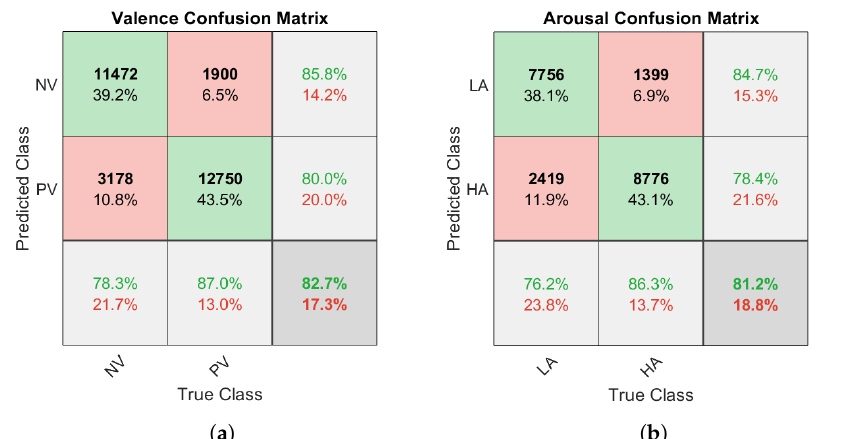
Figure 4. Confusion matrices for the 10-NN classifier in the valence ( a ) and arousal ( b ) dimensions. Figure 5a,b show the confusion matrices for the Ensemble Bagged Tree classifier for the valence and arousal dimensions, respectively. In this case, the overall accuracy is 89.4% for the valence and 89.2% for the arousal